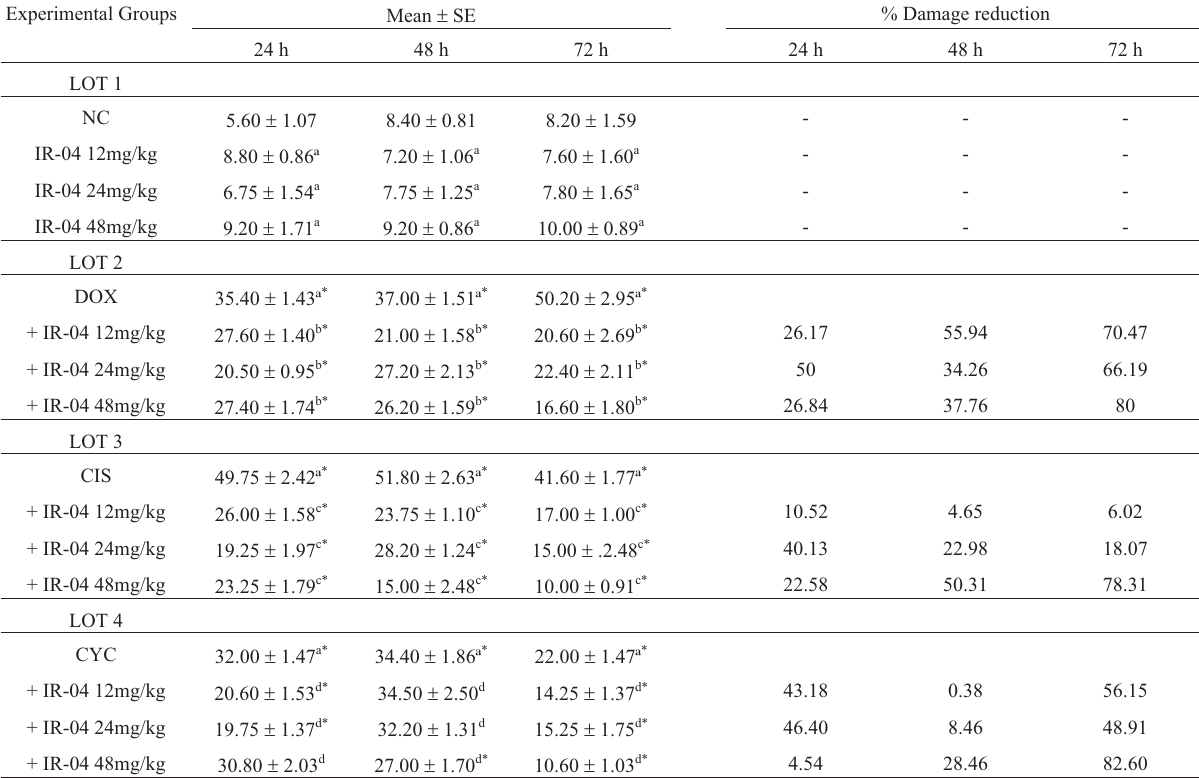
Table 2 - Results related to the ability of IR-04 in cause or prevent chromosomal damage through the micronucleus assay. Experimental